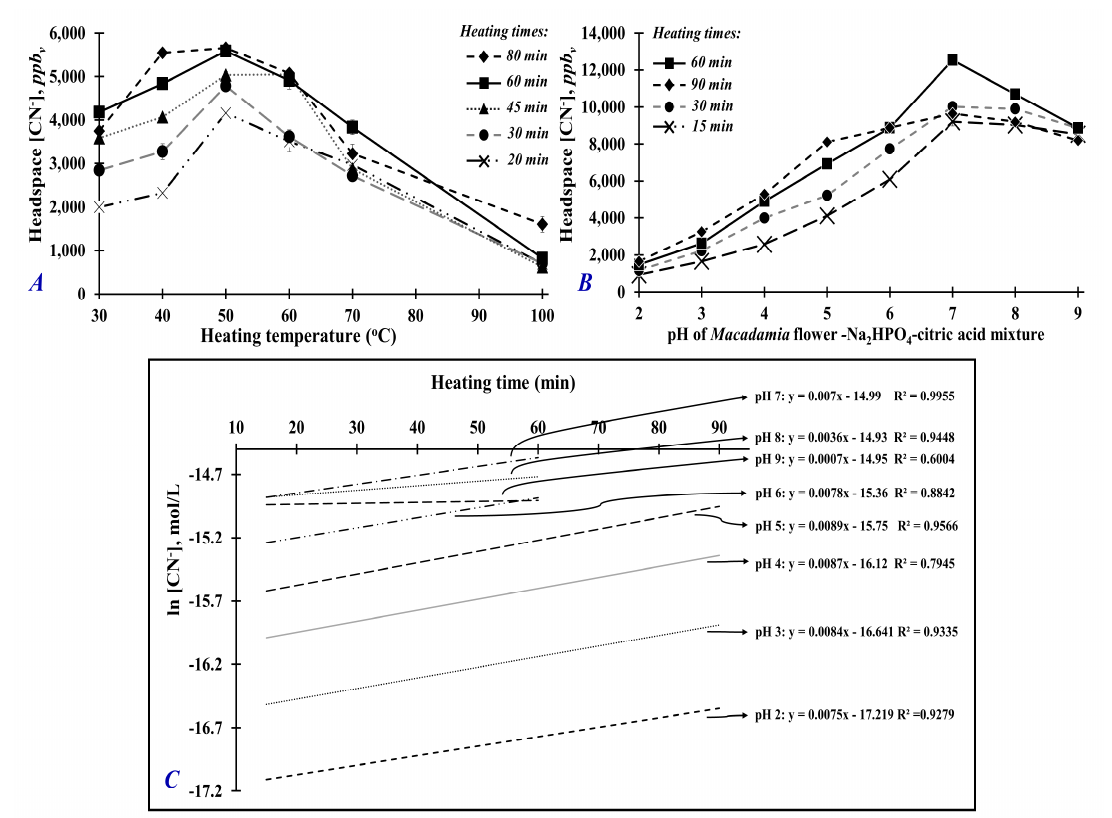
Figure 4. ( A ) Hydrogen cyanide (HCN) concentration in the headspace of Macadamia flower heated at various temperatures (30, 40, 50, 60, 70, and 100 °C) and different heating times (20, 30, 45, 60, and 80 min). ( B ) Hydrogen cyanide concentration in the headspace of Macadamia flower treated with Na 2 HPO 4 –citric acid mixture buffered at different pH (2, 3, 4, 5, 6, 7, 8, and 9) and heated at 50 °C for 15, 30, 60, and 90 min heating times. ( C ) Hydrolysis reaction rate analysis using [HCN, mol/L] concentration analyzed in the headspace of Macadamia flower treated with Na 2 HPO 4 –citric acid mixture buffered at different pH (2, 3, 4, 5, 6, 7, 8, and 9) and heated at 50 °C for 60 min. Standard error analysis was evaluated at 95% confidence intervals.